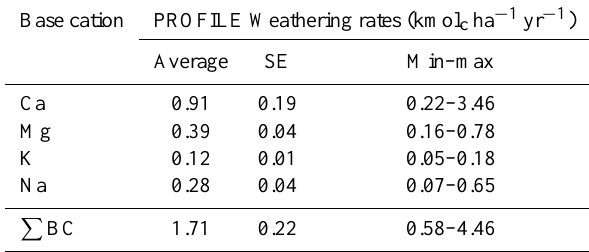
Table 4. Weathering rates obtained with the PROFILE model for the 21 individual